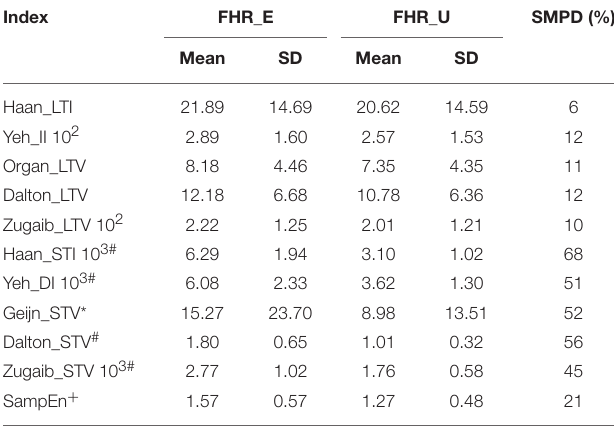
TABLE 3 | Results of the FHR_E and FHR_U signal analysis, concerning the long- and short-term variability, calculated using signal in a form of time event series—a sequence of events unevenly localized in time, together with the SMPD values estimating the inconsistencies between both the methods.